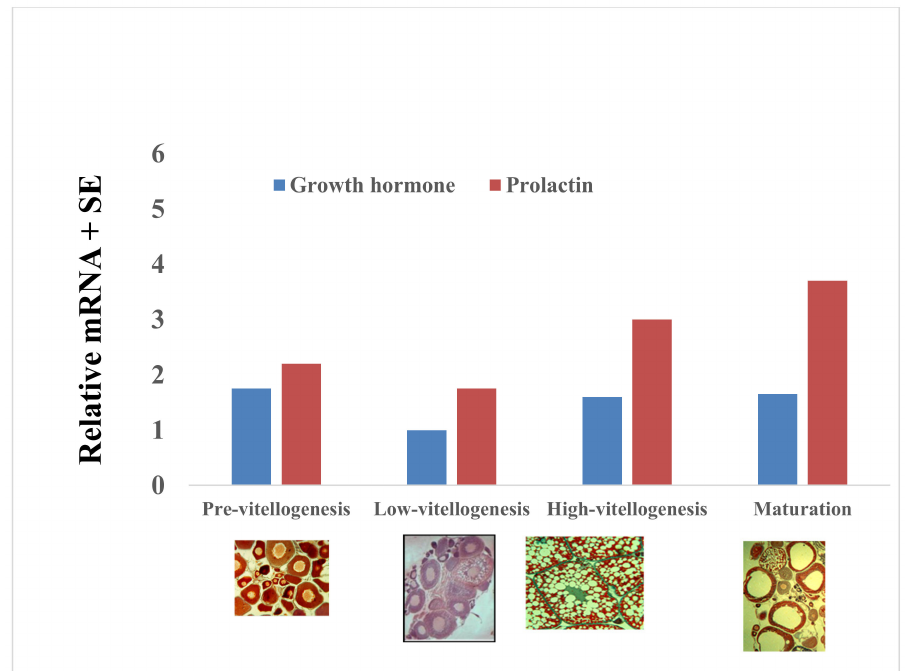
Figure 9. Variations in GH and prolactin mRNA levels during the gonadal cycle (X 8.5 × 10 − 6 ): pre-vitellogenesis (PV), low vitellogenesis (LV), high vitellogenesis (HV), and maturation (MS). Each histogram represents the average of five independent measurements (mean ± SE)